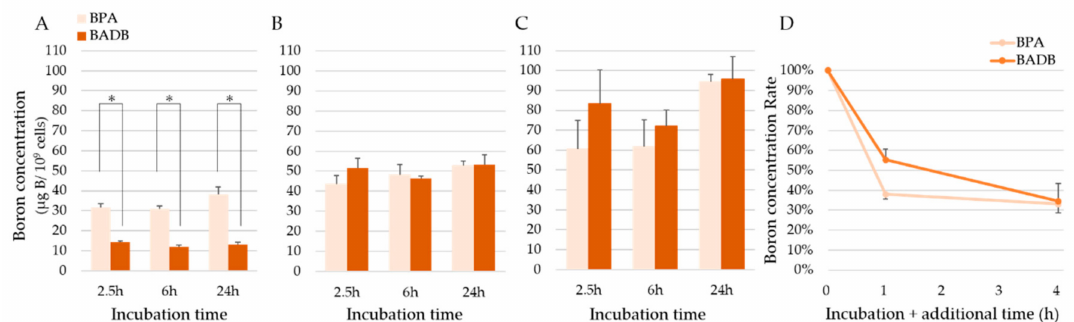
Figure 2. Cellular uptake of boron in F98 glioma cells: ( A ) To discern the cellular uptake of boronophenylalanine (BPA) and BADB, F98 cells were incubated with 5 µ g B / mL of BPA and BADB for 2.5, 6, and 24 h. * p < 0.005 by Student’s t -test. ( B ) To discern the cellular uptake of BPA and